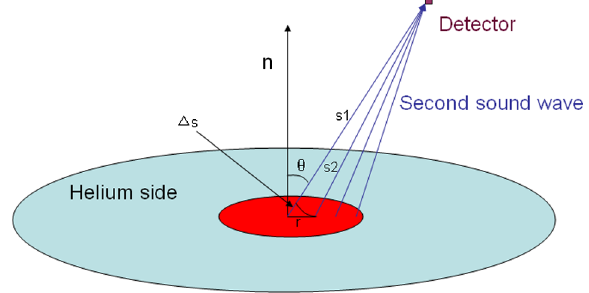
FIG. 3. Second sound signal from different position of niobium sheet.